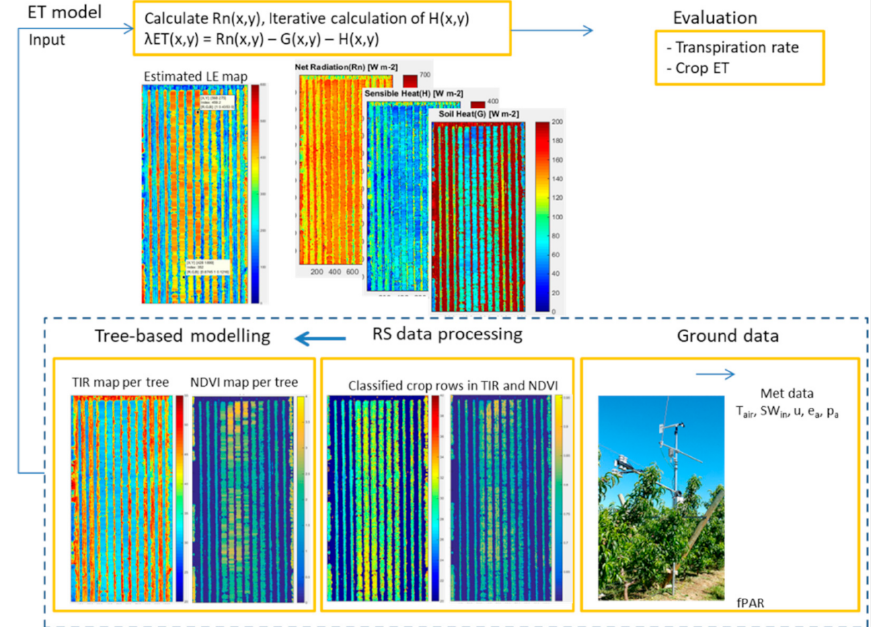
Figure 3. Flow of data processing and